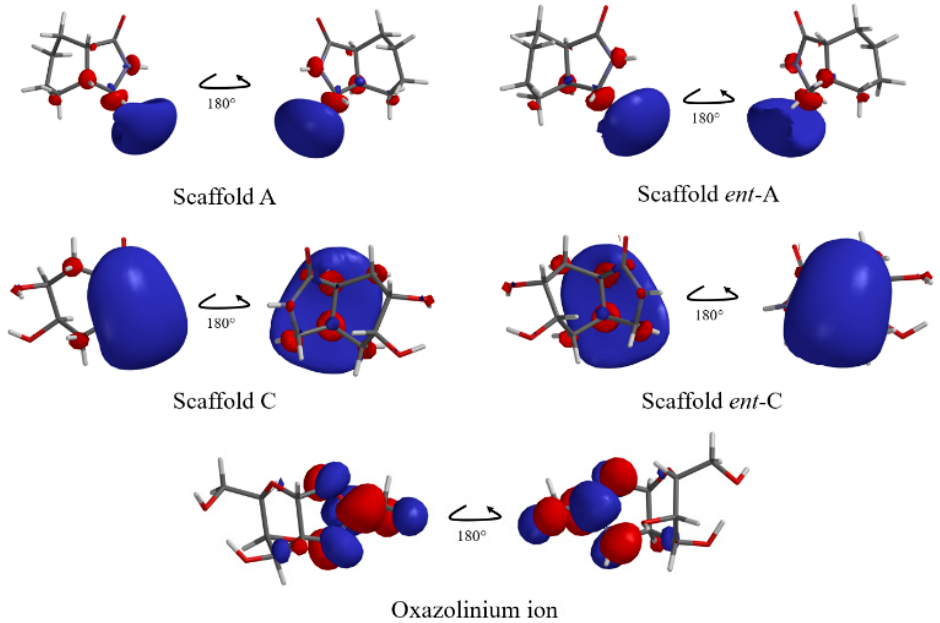
Figure 9. Lowest Unoccupied Molecular Orbital graphic of the scaffold pro posals and the oxazolinium ion. Shape and size of the graphics shows the contribution to the LUMO of each atom in the molecule.